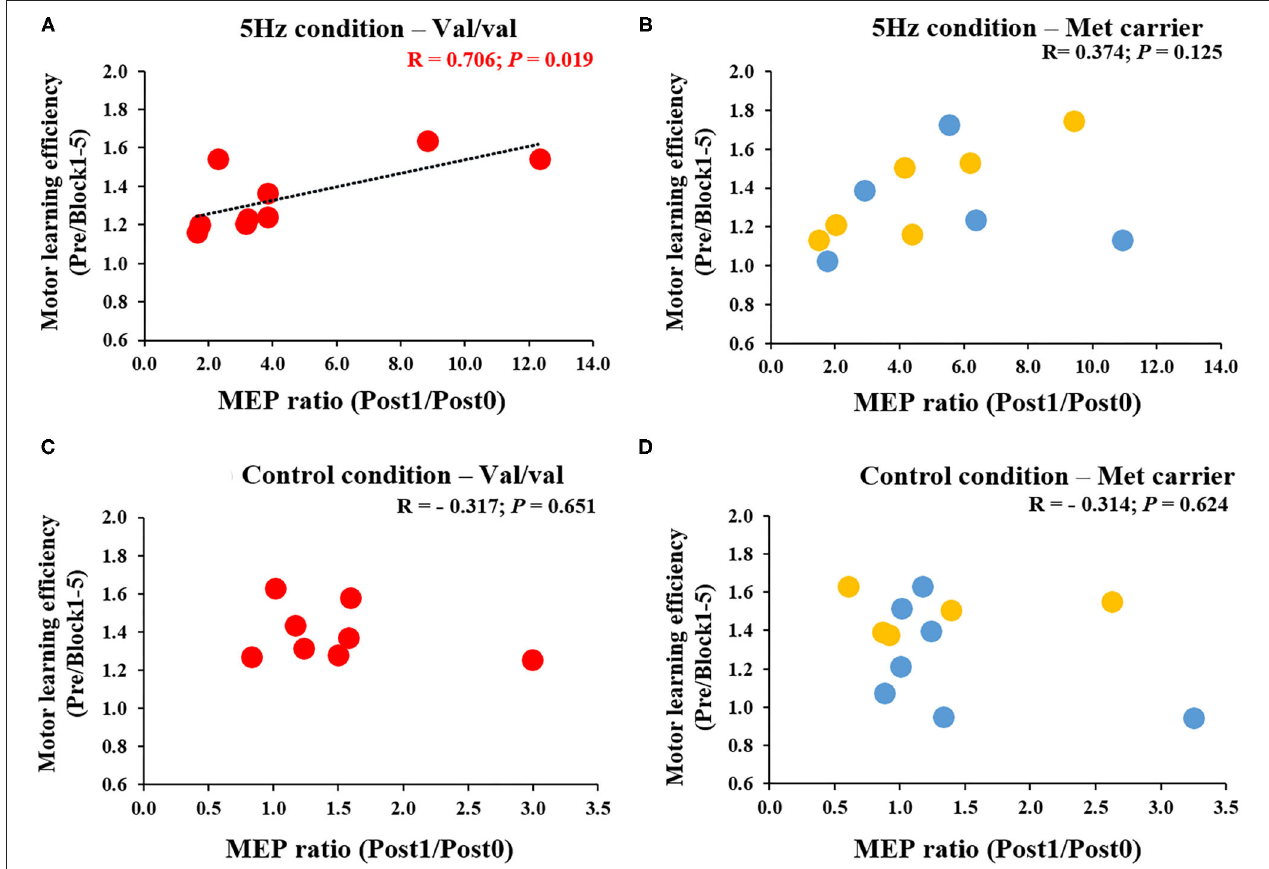
FIGURE 6 | (A–D) Correlation between MEP ratio (Post1/Post0) and motor learning efficiency in carriers of each of the genetic polymorphisms of BDNF . The red circles indicate the Val/Val genotype, whereas the blue circles indicate the Val/Met genotype, and the yellow circles indicate the Met/Met genotype. There was a significant correlation between MEP ratio and motor learning efficiency before and after motor learning task in the RPM condition only for Val/Val genotype carriers ( r = 0.706; P = 0.019). These results indicate that in the Val/Val form in the RPM condition, corticospinal excitability was more likely to be increased in individuals whose task errors were reduced by motor learning